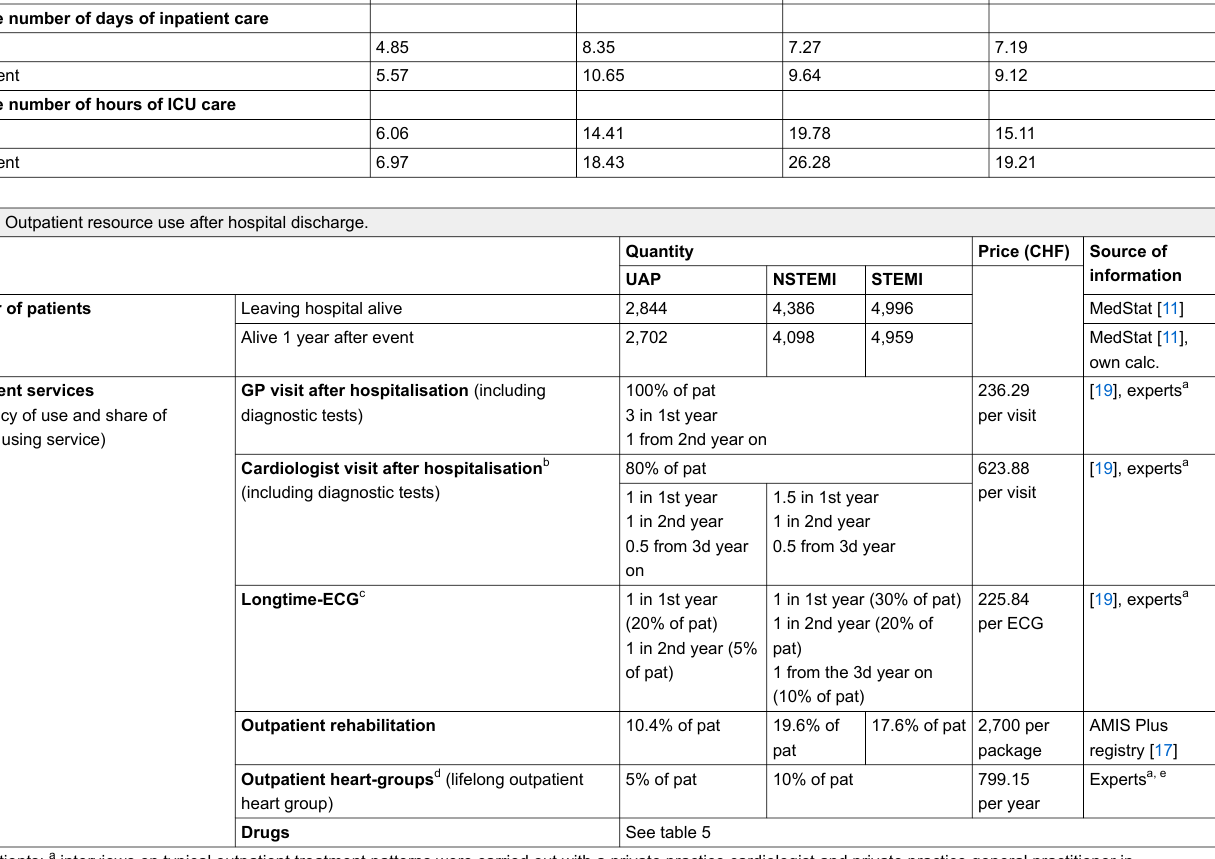
Table 3: Average length of stay in acute care hospital and average hours in ICU of ACS patients in 2008 (per stay and per patient). Own calculation on MedStat [11]. Length of stay differs significantly if calculated per number of stays or number of patients. UAP NSTEMI STEMI all ACS